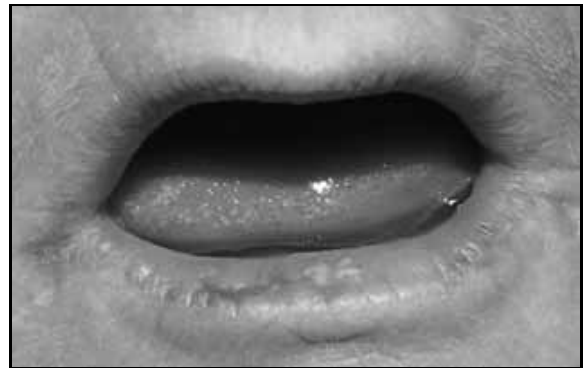
Figura 1 – Paciente 7: lesão eritematosa extensa com área de úlcera rasa na região paramediana direita e placa branca na região central do lábio inferior, além de fissura bilateral em comissura labial (queilite